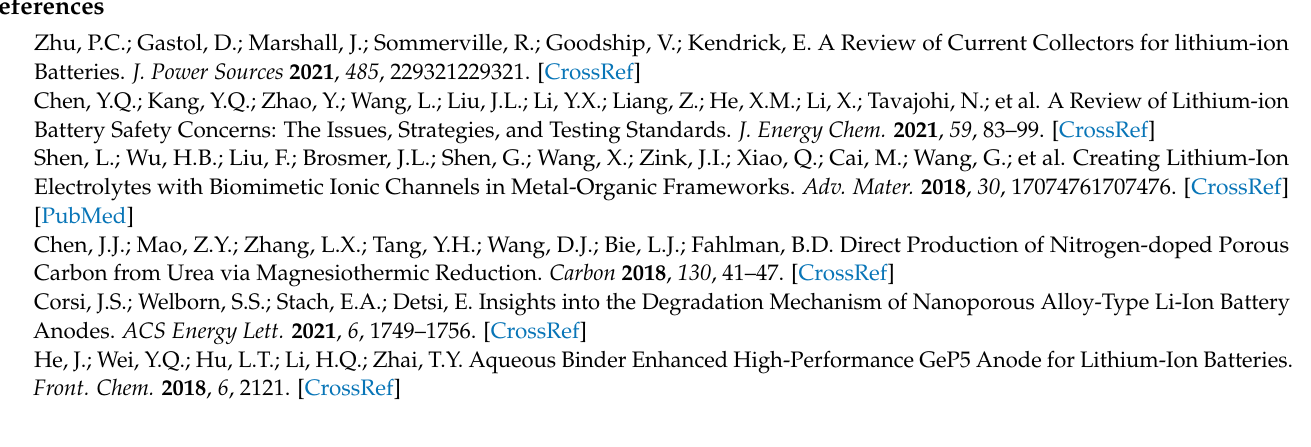
Figure S3: CV (left) and charge/discharge curves (right) of the samples, Figure S4: (a,b,c,d) SEM mi- crograph of electrode, (e) XRD patterns of the electrodes, Figure S5: The cycle performance of different amounts of Zn-doped Ni-PTA, Table S1: Induced coupled plasma atomic emission spectroscopy (ICP- AES) results of the Zn-doped Ni-MOF, Table S2: The surface area (BET) of the Zn x -Ni-MOF, Table S3: Summary of metal-organic frameworks reported as anode materials in rechargeable lithium-ions batteries. References [41–51] are cited in the supplementary